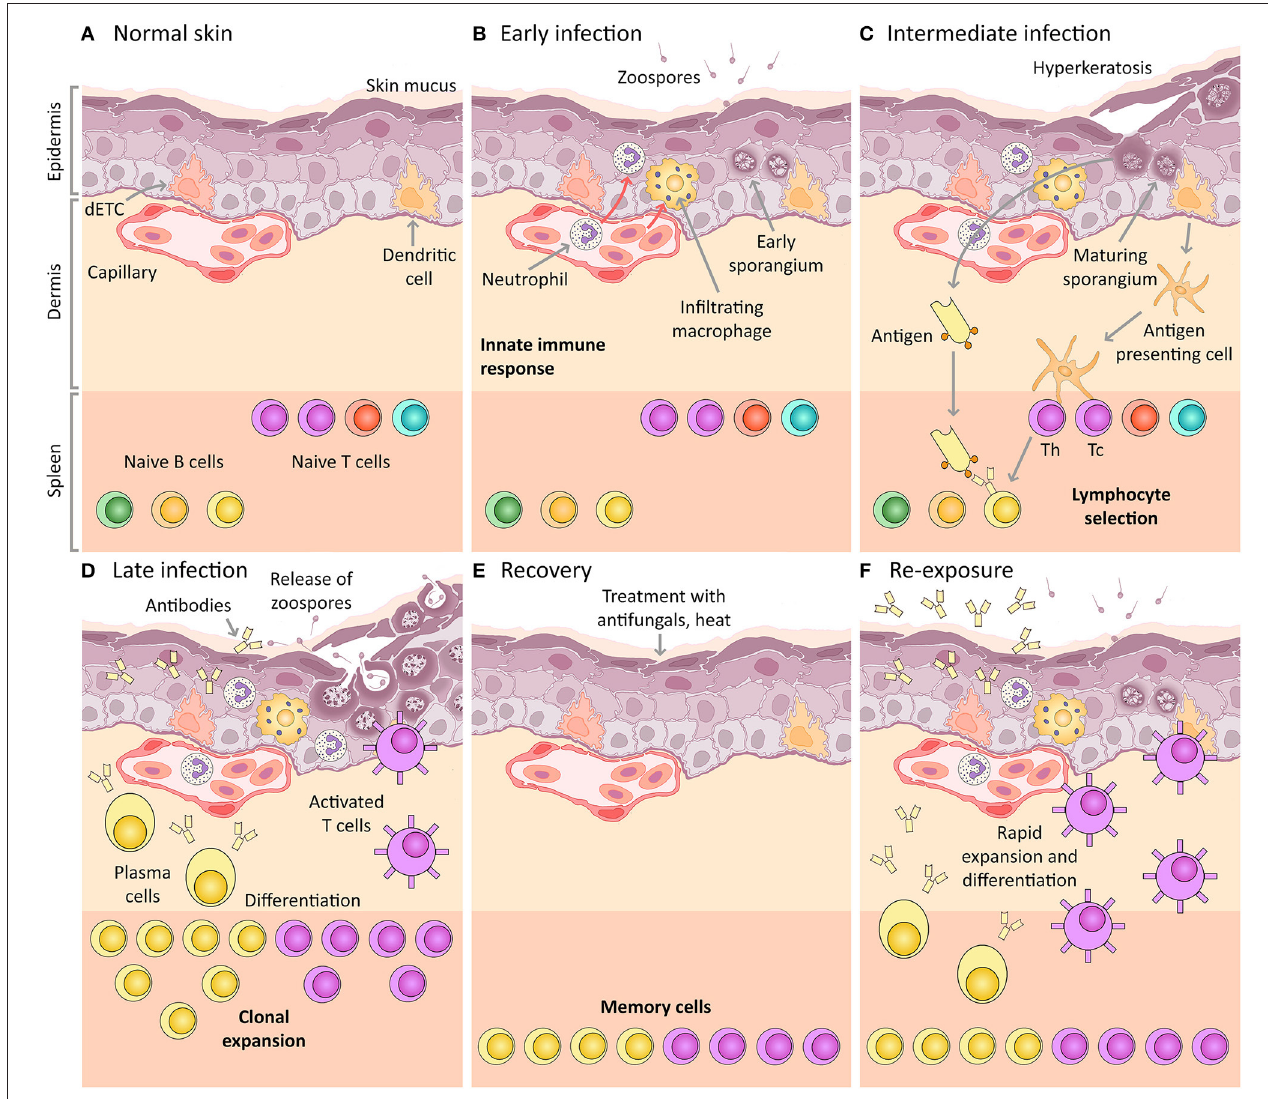
FIGURE 1 | Amphibian host immunity schematic, depicting a histological section through the skin and progressive infection stages with Bd. The inference of the main cellular components is based on mammalian immunology and an expected “normal” immune response (including the expected response to vaccination). (A) Normal skin: Layers of uninfected frog skin epidermis including, from deepest to most superficial, the basal lamina , stratum germinativum , stratum spinosum , stratum granulosum , stratum corneum and the superficial mucus layer. Two immune surveillance cells are illustrated within the epidermis, an immune dendritic cell (homologous to Langerhans cell), and a dendritic epidermal T cell (dETC). Within the dermis is a capillary with the nucleated red blood cells of amphibians. An example complement of naïve B and T lymphocytes are depicted waiting quiescent in the spleen, illustrated schematically as the lower band on the figure (please note that the spleen is a separate organ and does not lie adjacent to the dermis in living amphibians). (B) Early infection: Expected immune mechanisms upon initial exposure to Bd, assuming constitutive defenses (such as AMPs and bacteria) are insufficient. Zoospores are illustrated penetrating the mucus layer, and early thalli with zoosporangia developing are illustrated inside deeper host cells. In a normal immune response, pathogen recognition should lead to the infiltration of innate immune cells, illustrated here to include macrophages and granulocytes (such as neutrophils). (C) Intermediate infection: Expected response at an intermediate stage of infection includes the recognition of antigens by dendritic cells that then differentiate into antigen presenting cells and migrate to the spleen enabling antigen-specific selection of lymphocytes. Simultaneously, membrane-bound immunoglobulin on naïve B lymphocytes is exposed to extracellular Bd antigens (transported via the blood circulatory and lymphatic systems). With the assistance of T helper cells, these B cells are activated to respond to infection. (D) Late infection: The late adaptive response involves lymphocyte clonal expansion, differentiation into plasma cells and activated T cells (including cytotoxic and helper T cells), as well as the production of antibodies by plasma cells. (E) Recovery: If the frog is cleared of infection (perhaps by topical antifungals or heat), the skin might be expected to return to normal, however, a cohort of selected memory lymphocytes should remain. (F) Re-exposure: If the frog is then later re-exposed to Bd, the memory lymphocytes (produced during the previous clonal expansion) are then activated and induced to replicate and differentiate, leading to a much more rapid and effective adaptive immune response on re-exposure. This is the concept of immunization (vaccination).